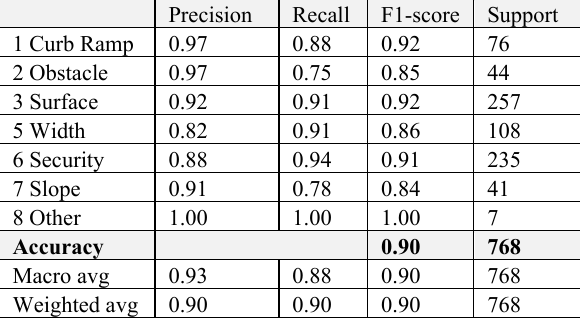
Table 3. 2nd model reaches a performance of 90%